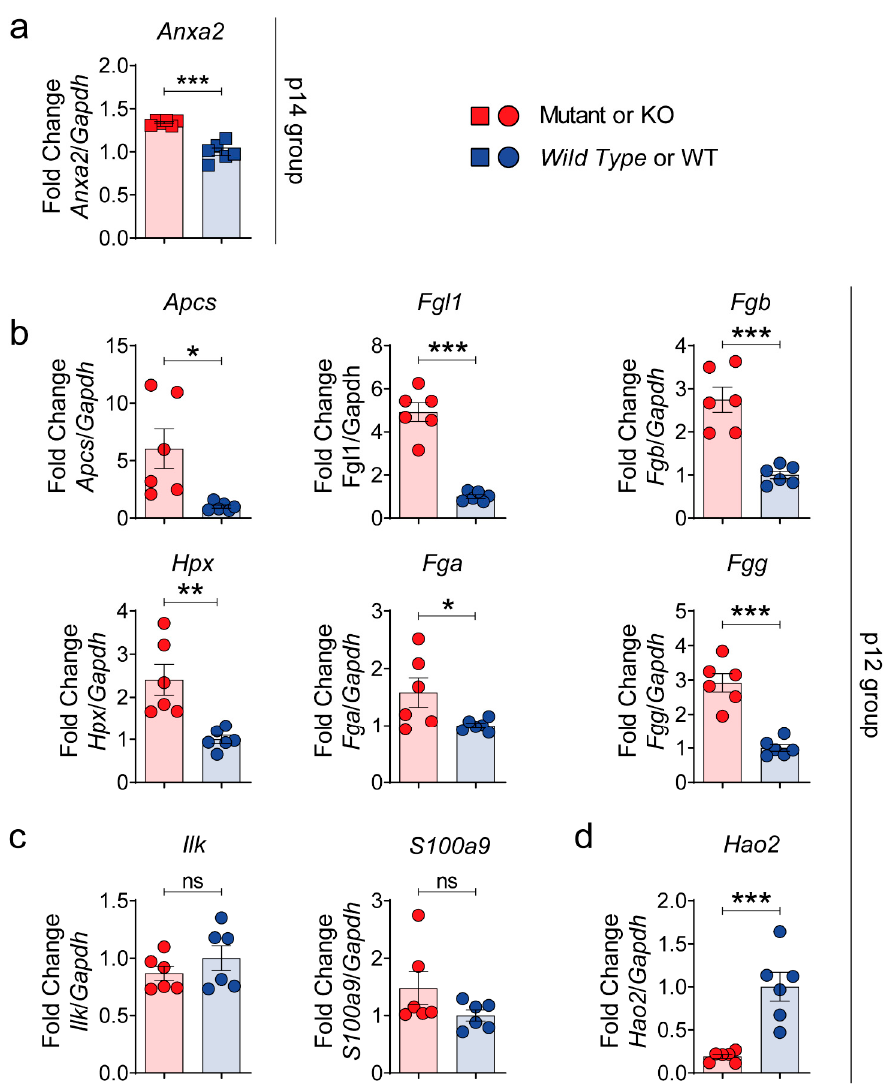
Figure 5. Validation of possible PLD targets by RT-qPCR. Gene expression of 8 to 10 selected targets correlated with SWATH-MS data. RT-qPCRs of up-regulated selected p14 target annexin A2 ( Anxa2 ) ( a ); up-regulated p12 targets amyloid p component, serum ( Apcs , SAMP gene), fibrinogen-like 1 ( Fgl1 ), fibrinogen beta chain ( Fgb ), hemopexin ( Hpx ), fibrinogen alpha chain ( Fga ), fibrinogen gamma chain ( Fgg ) ( b ), integrin linked kinase ( Ilk ) and S100 calcium binding protein A9 ( S100a9 ) ( c ); and down-regulated p12 target hydroxyacid oxidase 2 ( Hao2 ) ( d ). n = 6 was used for each protein group. Gapdh was used as a housekeeping gene. Bars represent means ± SEM. Student’s t -test with two-tail was used and a value of p < 0.05 was considered significant. ns: not significant ( p ≥ 0.05), * p < 0.05, ** p < 0.01, *** p < 0.001.